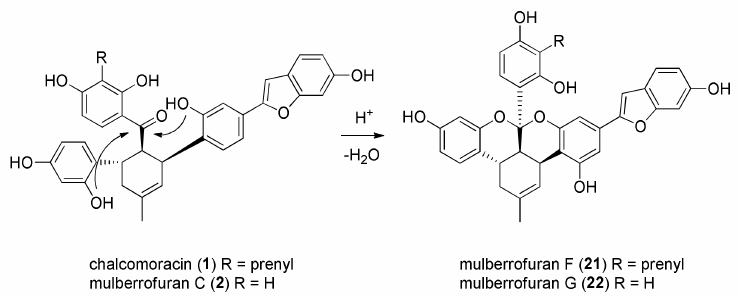
Figure 2. Formation of ketalized compounds from